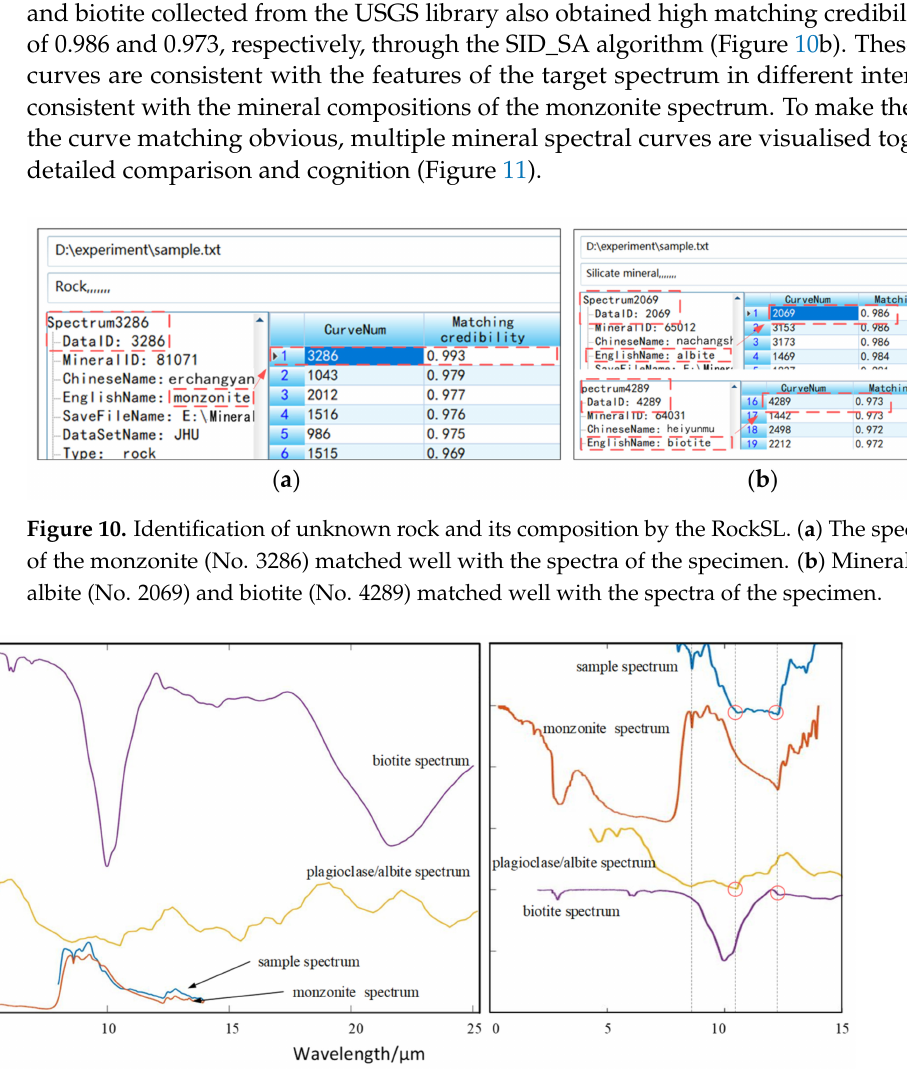
Figure 11. Identification of an unknown rock sample and its composition using the RockSL. The comparison between the sample spectrum and the reference spectrum, in which the monzonite spectrum and the sample spectrum roughly coincide ( left ). The sample spectrum and reference spectra after removing the envelope to highlight the absorption characteristics, and the positions of absorption peaks overlap ( right